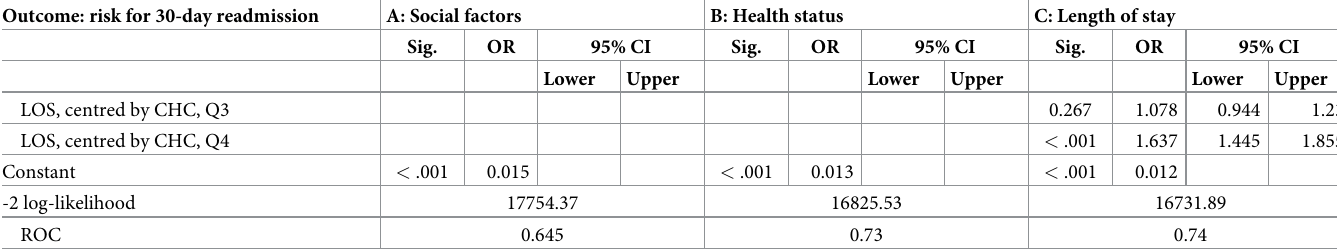
(Model B and C). Regarding type of household , patients living alone had higher odds for 30-day readmission compared to patients living with others when controlling for other social variables (Model A). This estimated risk was more than halved when health status variables were entered (Model B). When length of stay was entered (Model C), the difference collapsed and was no longer significant. Language skills showed no persistent effect on the 30-day read- mission rate, whereas age of patients increased the odds clearly (OR = 1.3 to 2.0 with increas- ing age, see Model C) and female sex reduced the odds slightly (OR = 0.90; 95% CI: 0.81, 0.99). Health status . Results of Model C show, that the estimated risk for unplanned 30-day read- mission was highest for patients with lung cancer (OR = 5.6; 95% CI: 4.5, 6.9) and congestive heart disease (OR = 2.8; 95% CI: 2.3, 3.4), followed by prostate and colon cancer, diabetes and COPD when compared to ischaemic heart disease, while patients with osteoarthritis showed the lowest 30-day readmission risk. On average, an increase in the number of somatic side diagnoses by one increased the risk for 30-day readmission (OR = 1.15; 95% CI: 1.11, 1.18), and having a mental comorbidity increased the risk by 19% (95% CI: 1.03, 1.37). A